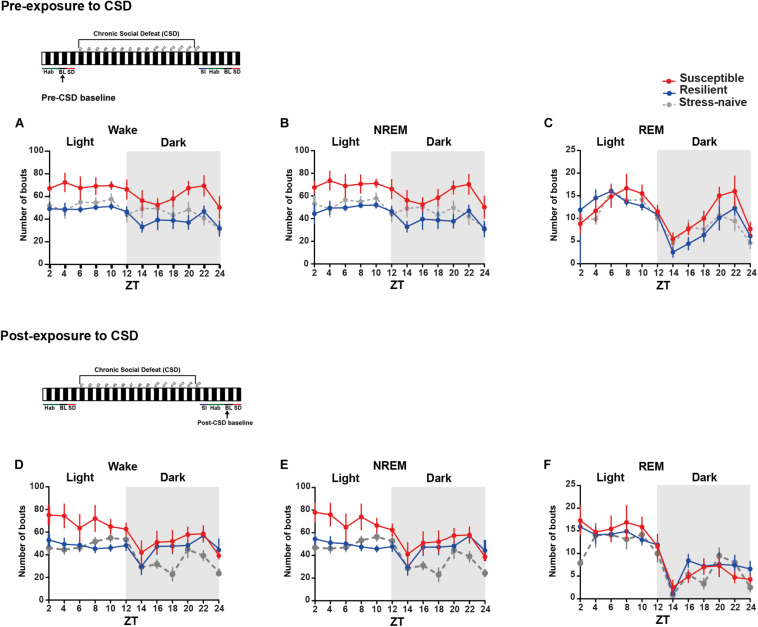
Mice susceptible to stress displayed greater number of wake and NREM bouts pre-and post-CSD stress. (A–C)
Pre-CSD stress: Susceptible mice displayed a higher number of (A) wake and (B) NREM bouts (F2,19 = 4.314, p < 0.05, and F2,19 = 4.456, p < 0.05, respectively). (D–F)
Post-CSD stress: (D) There was a trend of higher number of wake bouts in susceptible mice relative to resilient and stress-naïve groups (F2,19 = 3.395, p = 0.055). (E) There was “phenotype” effect in the number of NREM bouts (F2,19 = 4.275, p < 0.05). Values are expressed as the number of bouts across 2-h intervals (mean ± sem). n = 7–8 for each group.